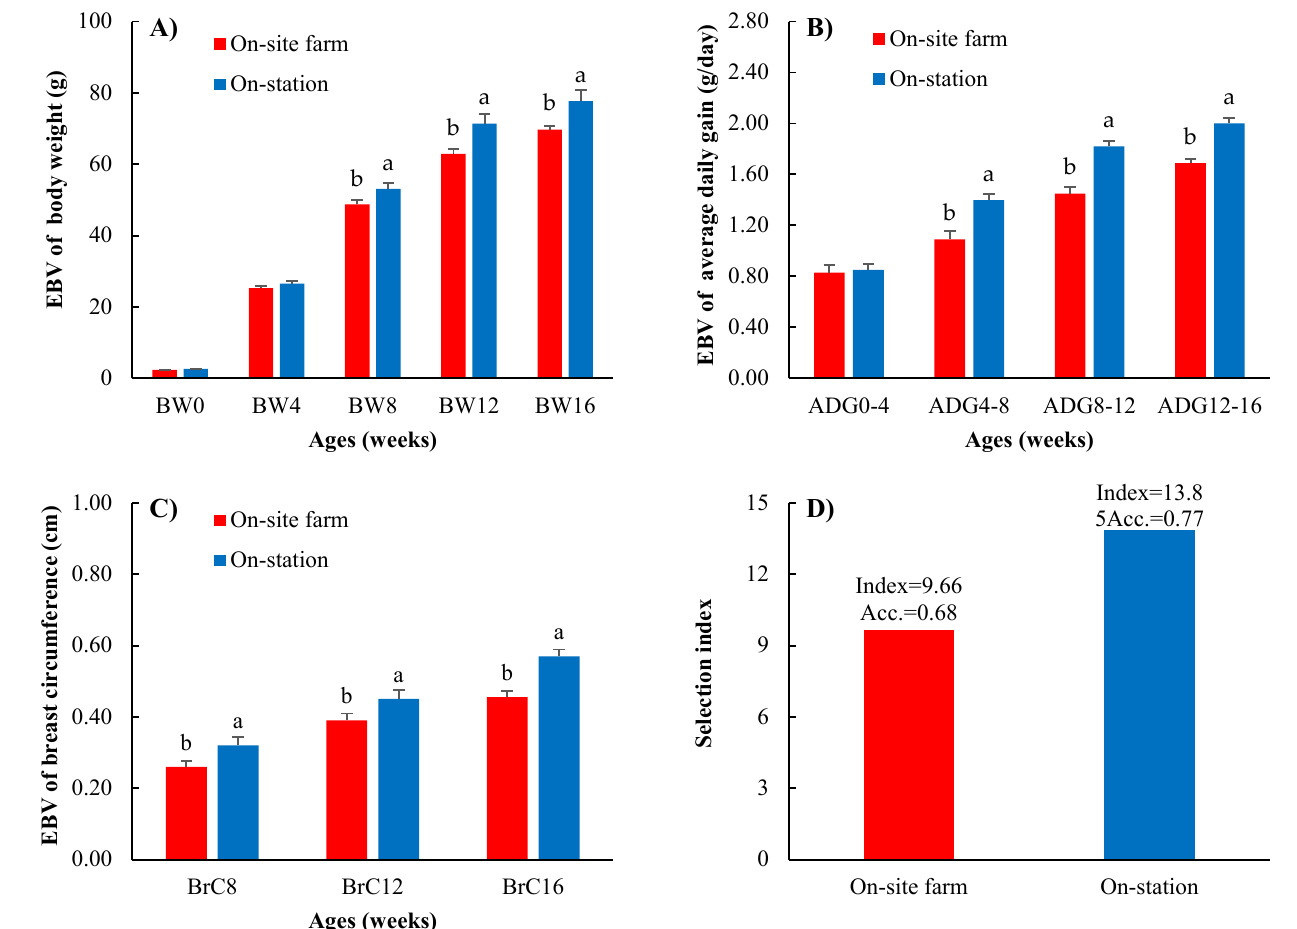
Figure 2. Top 20% estimated breeding values of ( A ) body weight, ( B ) average daily gain, ( C ) breast circumference, ( D ) selection index (Index) and accuracy of selection index (Acc.) between on ‐ site farm (red bar) and on ‐ station (blue bar) Thai native chickens (Pradu Hang dum). Means for the same trait with different letters (a, b) differ significantly ( p < 0.05).